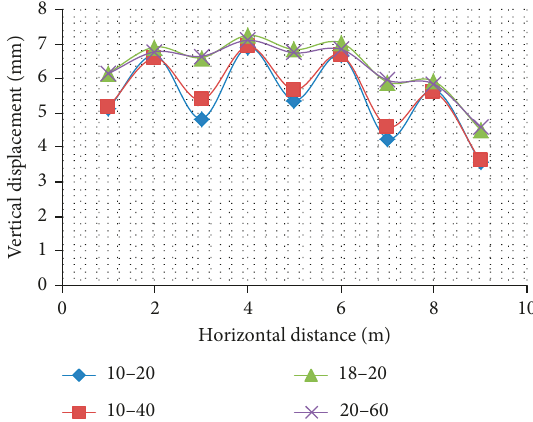
Figure 8: Relationship between the asphalt layer and pavement with uneven vertical